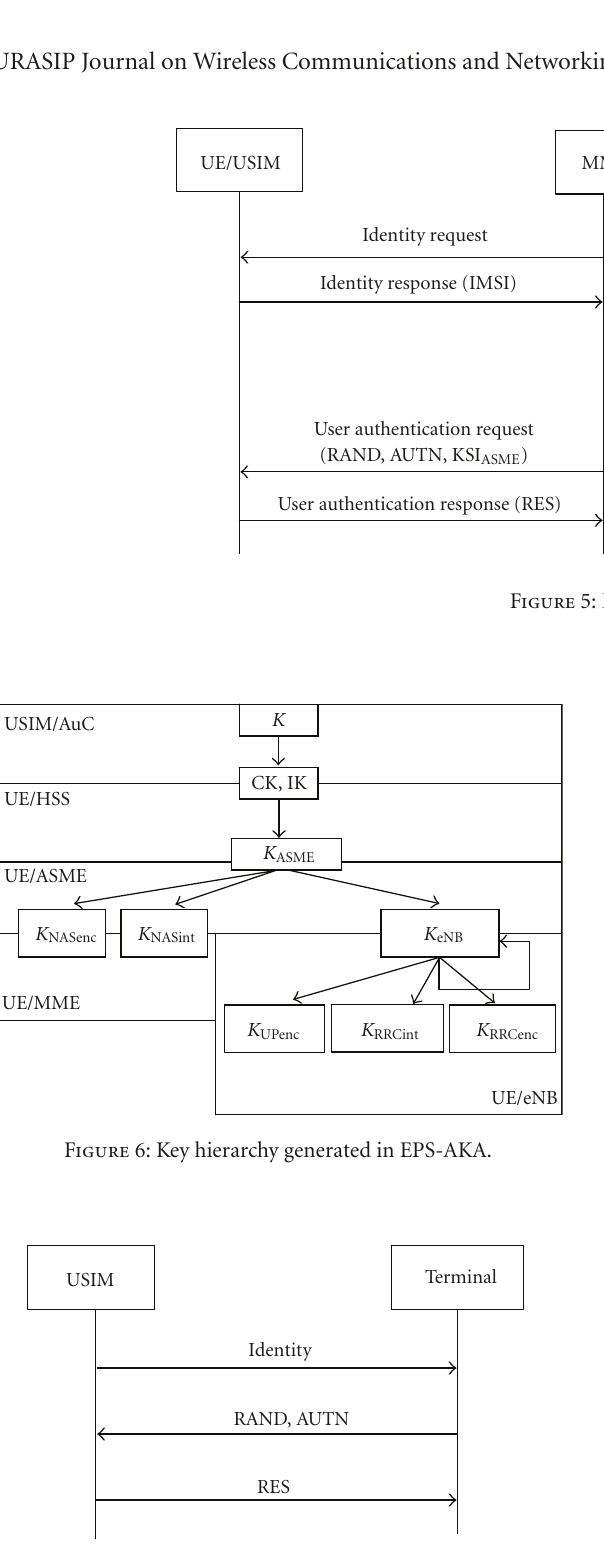
Figure 7: AKA algorithm on